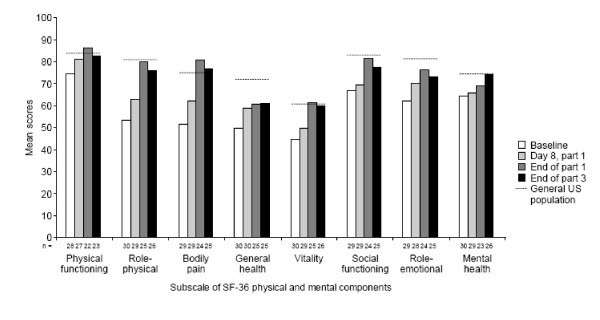
SF-36a domain scores at baseline and at the ends of part 1 and 3 in adults. aData are presented as the mean.